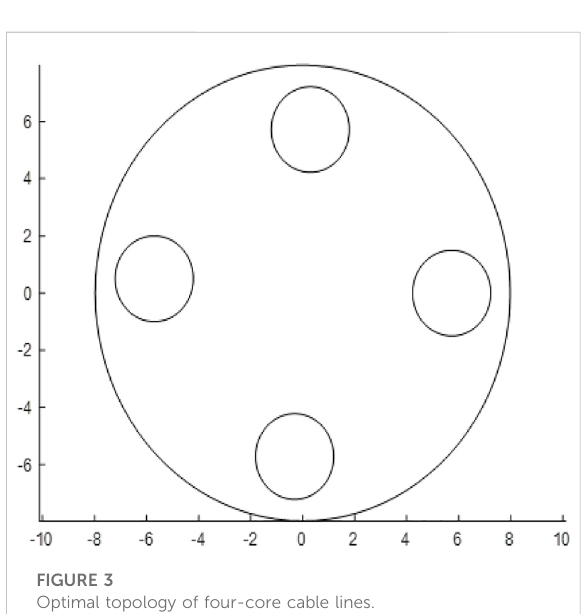
FIGURE 3 Optimal topology of four-core cable